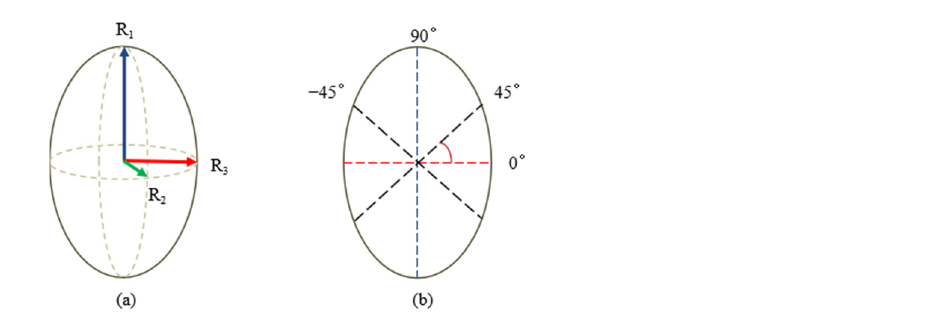
Figure 2. The ellipsoidal model of the A. pernyi cocoon ( a )three-dimensional ellipsoidal model; ( b ) areal ellipsoidal model.